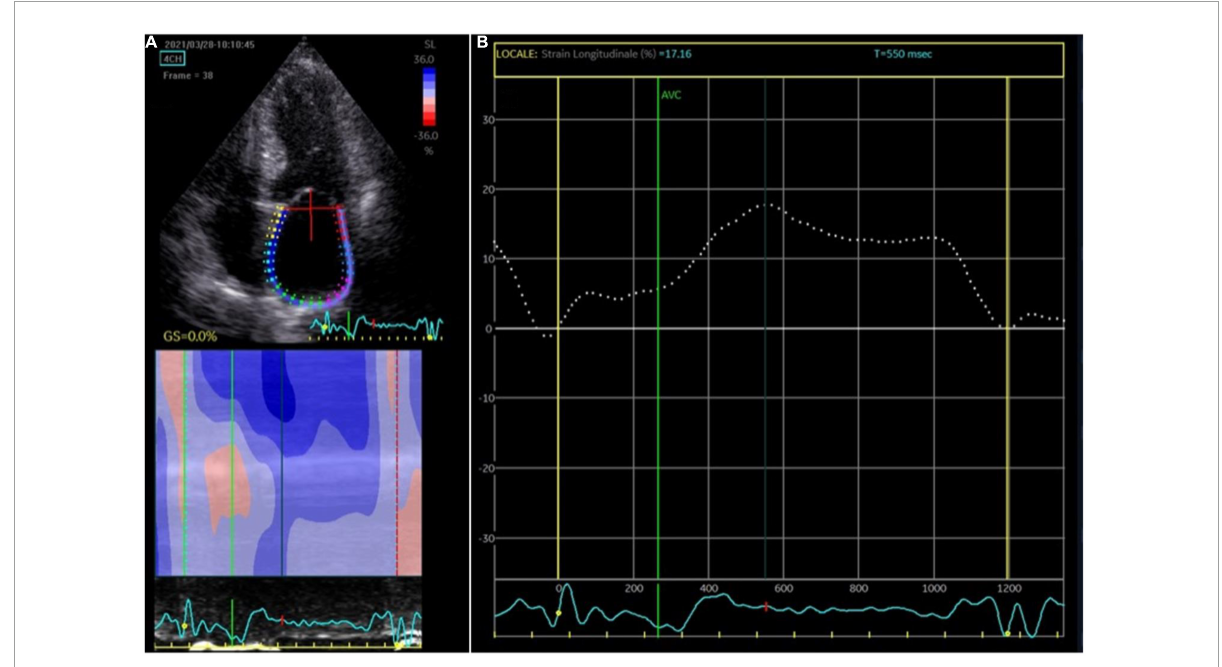
FIGURE1 Atrial strain measurement. (A) The apical four-chamber view was utilized for the strain measurements of the left atrium (LA); the edge of the LA endocardium was manually traced. (B) The software generated tracings based on the 2D strain of LA. The mean deformation (strain) is expressed in percentage and calculated by the software.